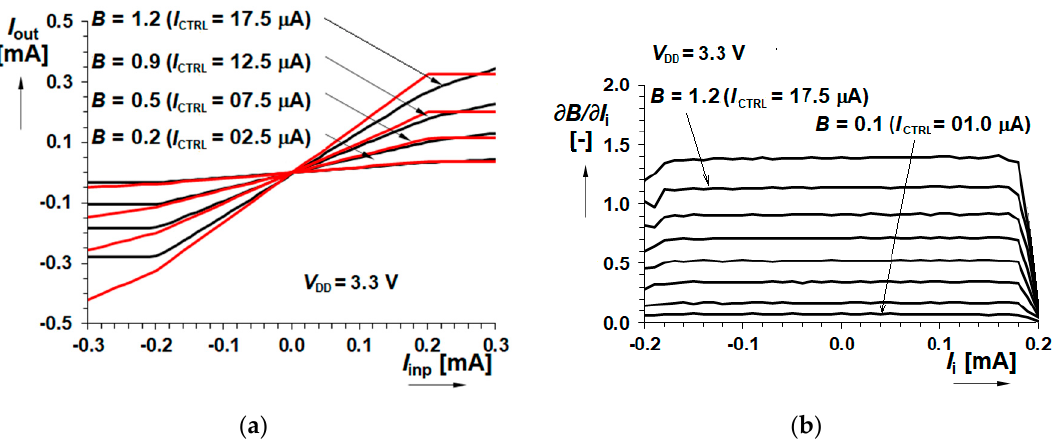
Figure 8. Measured DC transfer response ( a ) Comparison of the simulated (red) and measured (black) curves; ( b ) Measured gain across the input current range.